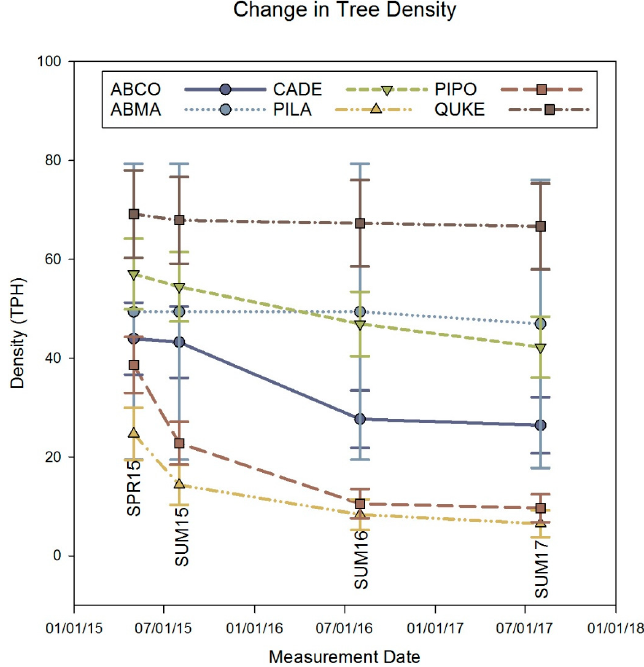
Figure 2. Mean ( ± 95% confidence interval (CI)) overstory (>25.4 cm DBH) density (trees per hectare) by species from Spring 2015 through Summer 2017 recorded across 255 plots in the Southern Sierra